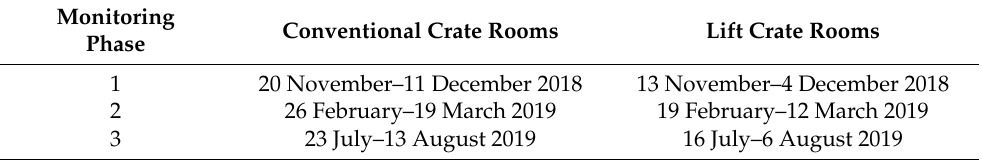
Table 1. Phases of the experimental study.